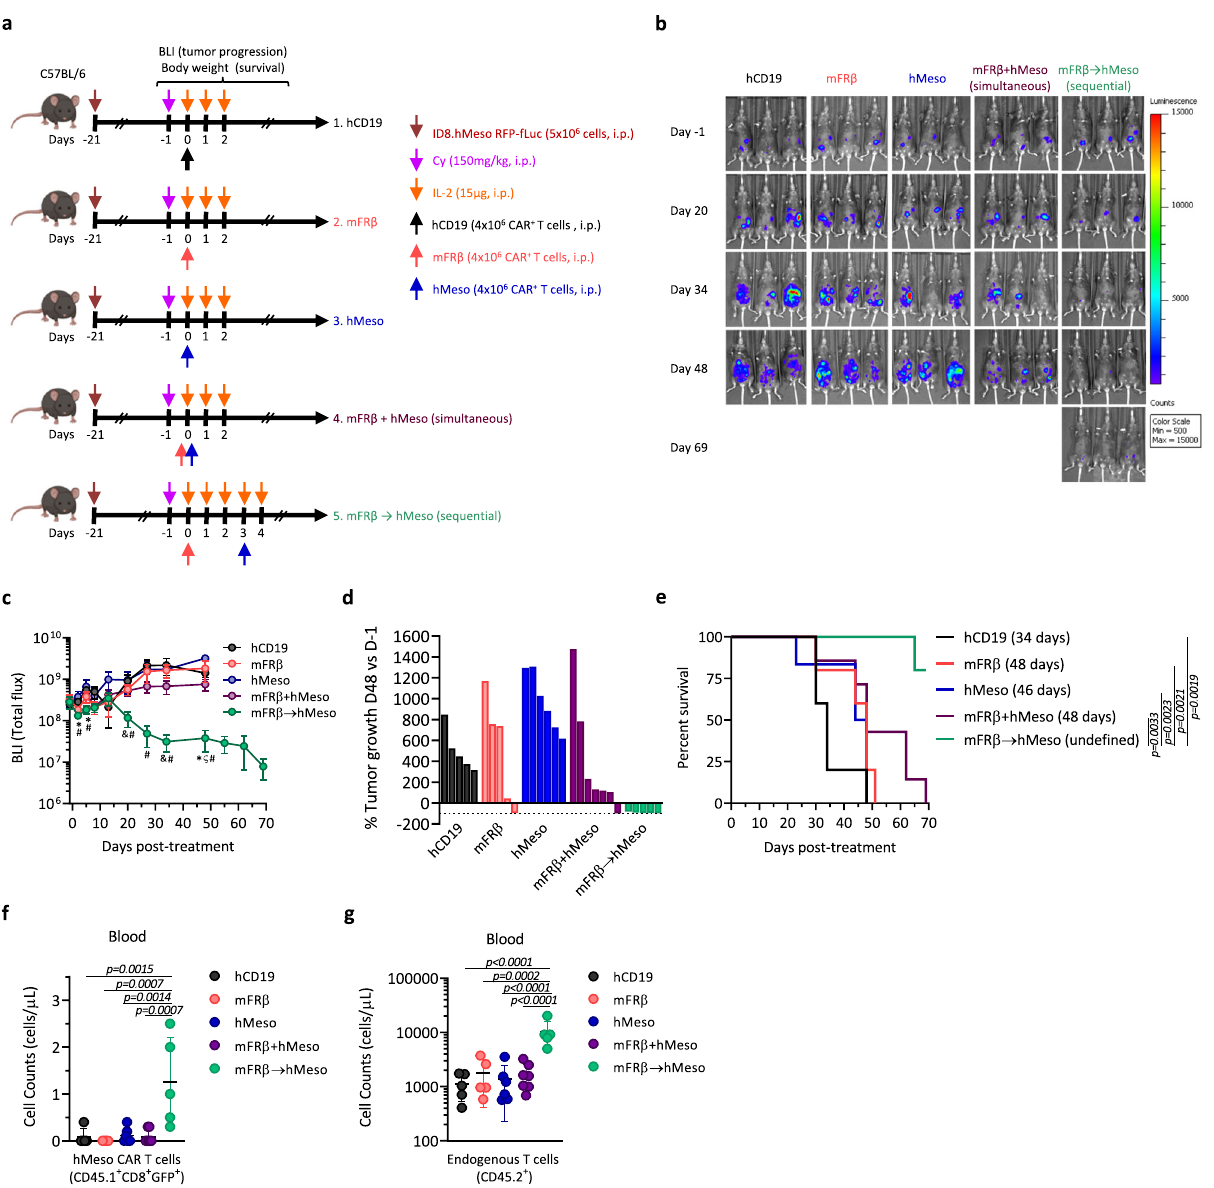
Fig. 6 Preconditioning the TME with anti-TAM CAR-T cells improves the ef fi cacy of tumor-speci fi c CAR-T cells. a Schematic representation of the in vivo study. Groups treated with only one of the CARs received an equivalent dose of UTD T cells to equal the total dose. hMeso CAR-T cells were prepared from CD45.1 donor mice ( n = 5 mice for hCD19, mFR β , and mFR β → hMeso groups, 6 for hMeso, and 7 for mFR β + hMeso). b BLI images from representative mice at indicated time points are shown. c Quanti fi cation of BLI shown as mean radiance ± SEM. d Waterfall plot showing the percentage of change in tumor BLI on day 48 vs. baseline (day − 1). Data from individual mice are represented. e Kaplan – Meier survival curves are represented. The endpoint was de fi ned at animal body weight increase >10% due to ascites formation. Mean survival is indicated in the legend. The concentration of f hMeso CAR + T cells (live, CD45.1 + /CD8 + /GFP + ) and g endogenous T cells (live, CD45.2 + ) were quanti fi ed in the blood of mice 9 days after administration of hMeso CAR-T cells and represented as mean ± SD. Experiment represented in panels ( a – e ) was performed twice. c P values were calculated by a multiple two-tailed t test (mFR β → hMeso as compared to (*) hCD19; (&) mFR β ; ( ζ ) hMeso; or (#) mFR β + hMeso) and exact values are indicated as follow: D2 * = 0.007, = 0.016; D5 * = 0.015, # = 0.036; D20 & = 0.046, # = 0.021; D27 # = 0.019; D34 & = 0.047, # = 0.040; D48 * = 0.020, ζ = 0.004, # = 0.024. P values by a e log-rank Mantel – Cox test or f , g a one-way ANOVA with Tukey ’ s multiple comparison test are indicated. Source data are provided in the Source Data fi cancer. The accumulation of FR β + TAMs appears to be in fl u- similar to the results obtained by Puig-Kröger et al. 25 using in enced at least, in part, by the presence of soluble factors produced by tumor cells in the TME that favor the polarization and recruitment of M2-like macrophages. In our studies, FR β expression was signi fi cantly upregulated in vitro by culturing peritoneal macrophages from naive mice in the presence of supernatants from ID8 tumor cell cultures. This observation is tasis 34 . In addition, our fi ndings showing a correlation between